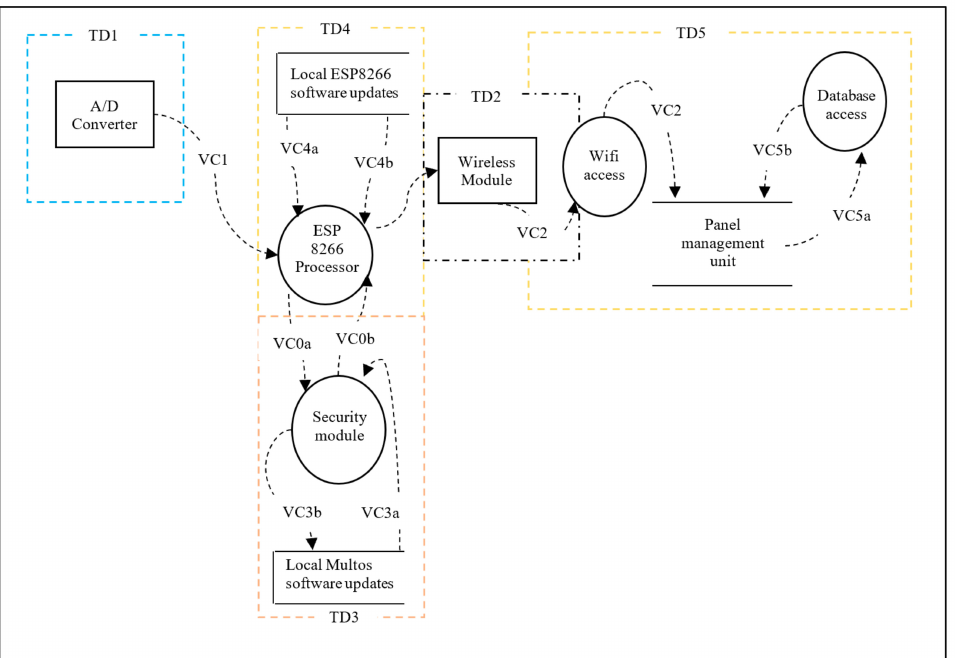
Figure 16. Daedalus Data Flow Diagram with security